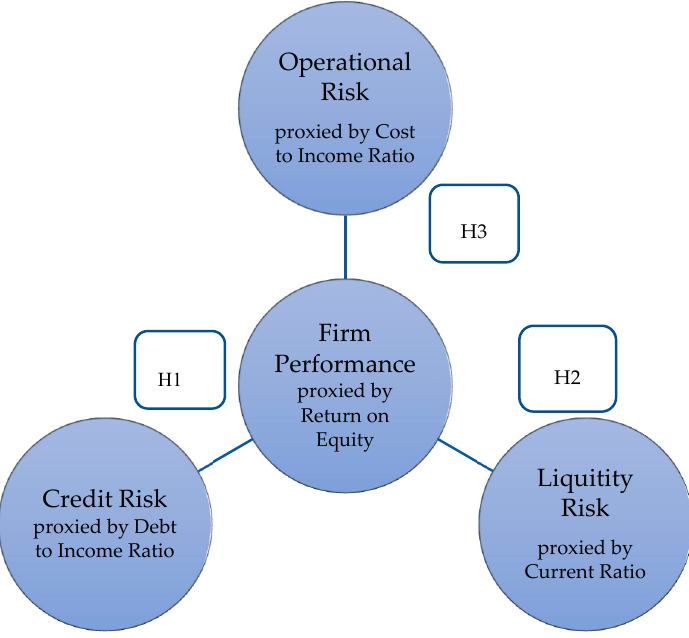
Figure 1. Conceptual framework.